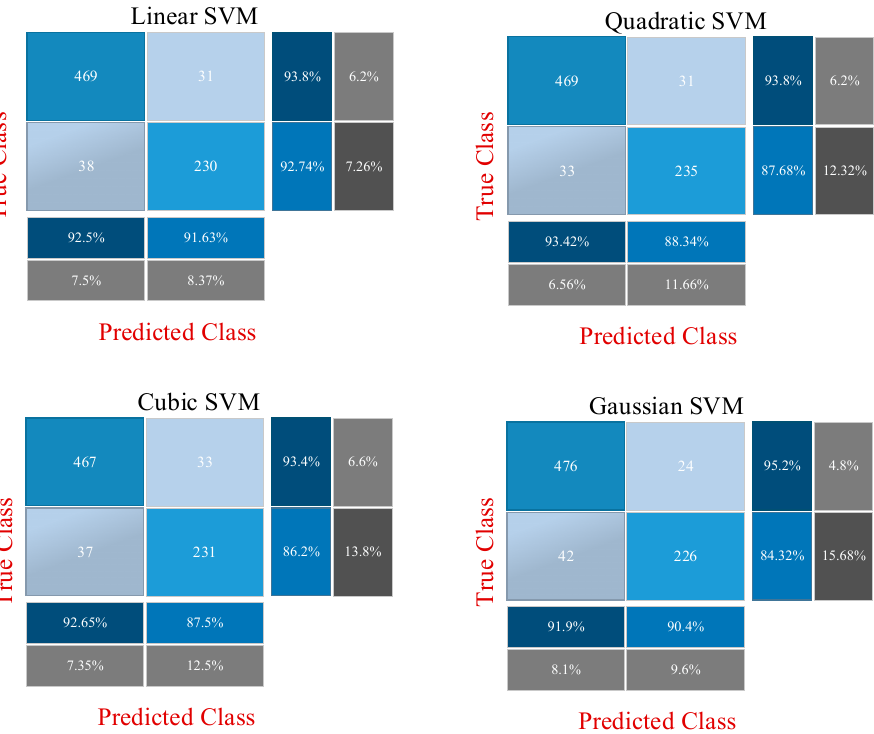
Figure 10. Confusion matrices obtained as a result of classification of all fused features with SVM.